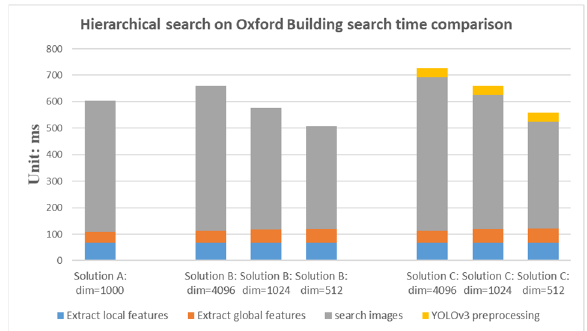
Figure 10. Time-consuming comparison of three hierarchical retrieval Solutions on the Mixed